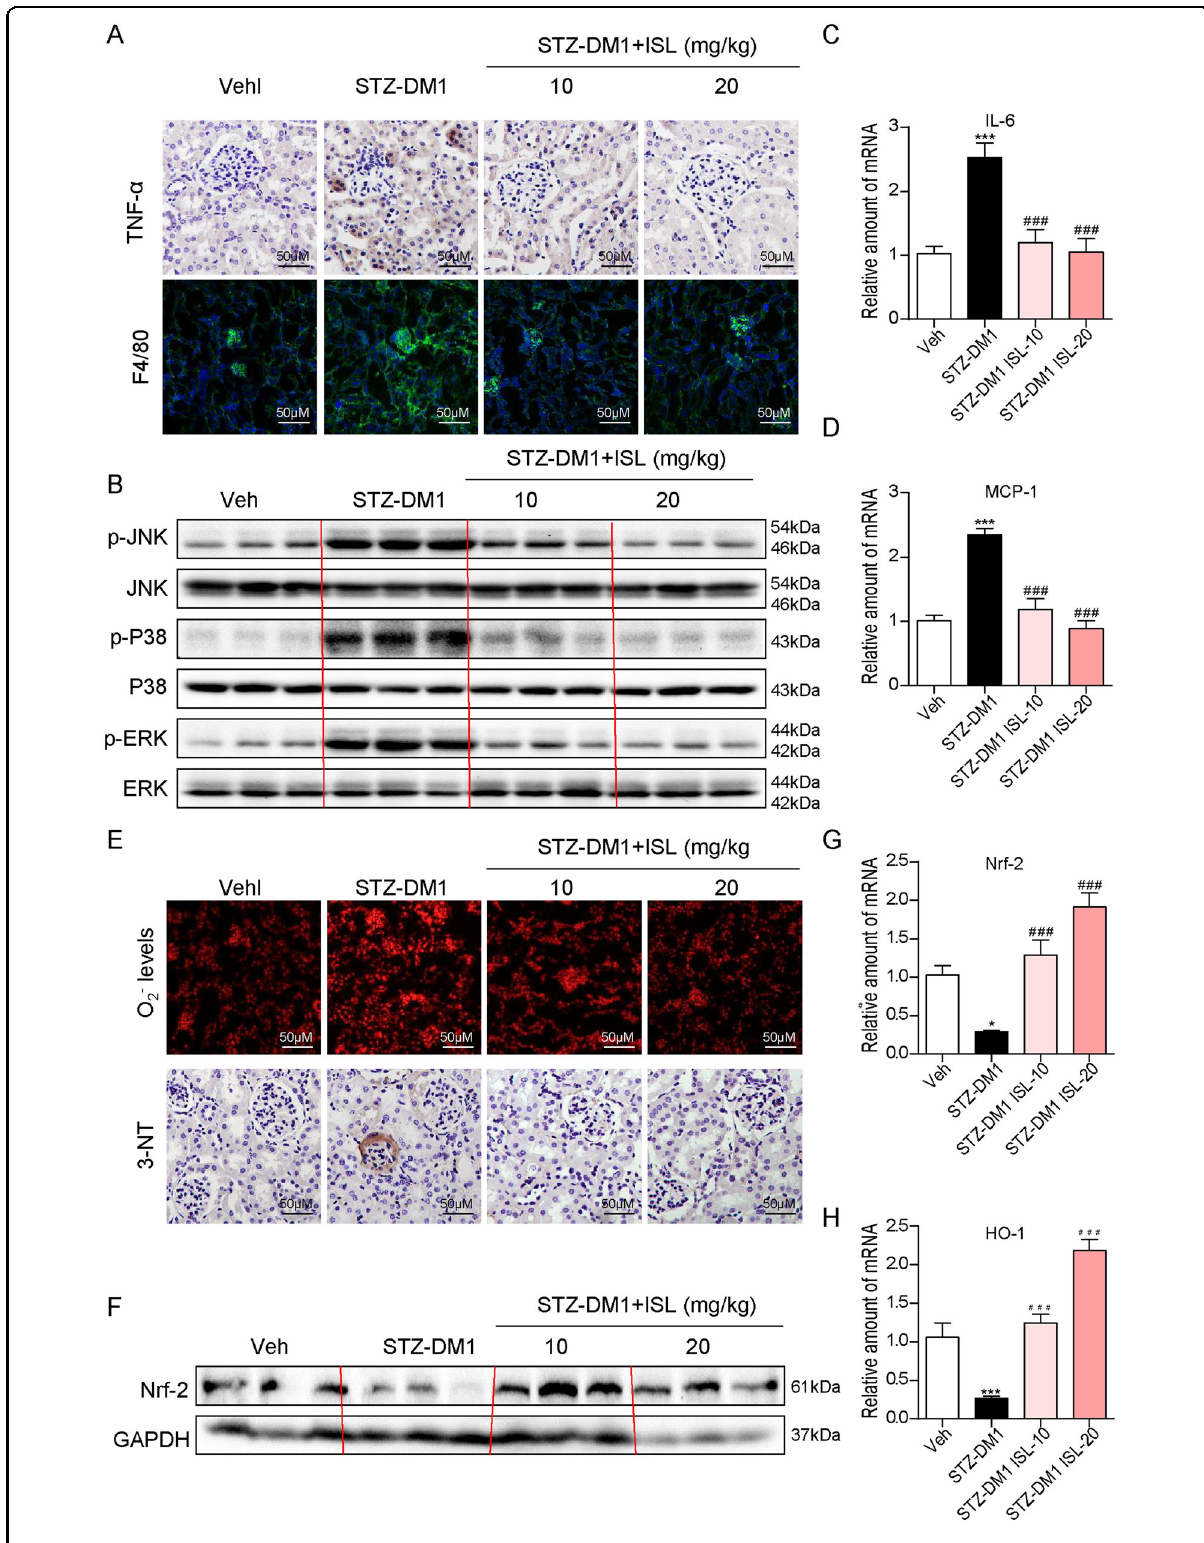
Fig. 3 (See legend on next